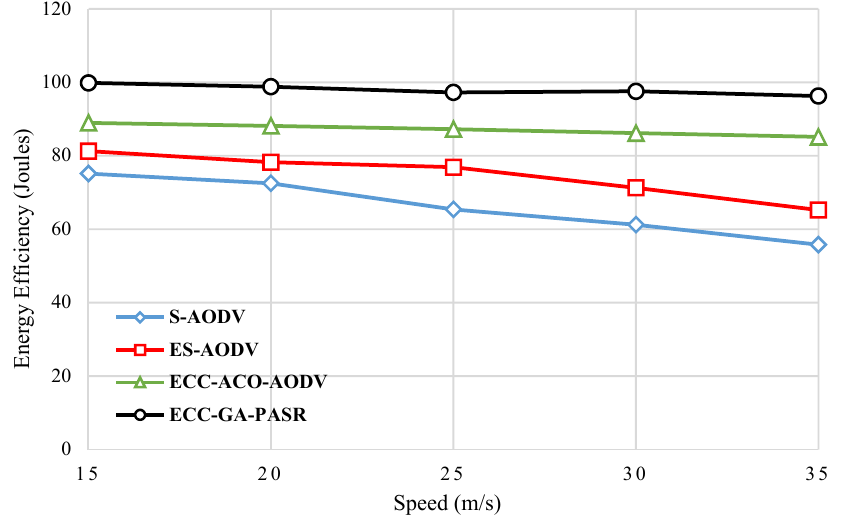
Figure 13. Efficiency Calculation based on vary speed of vehicle.